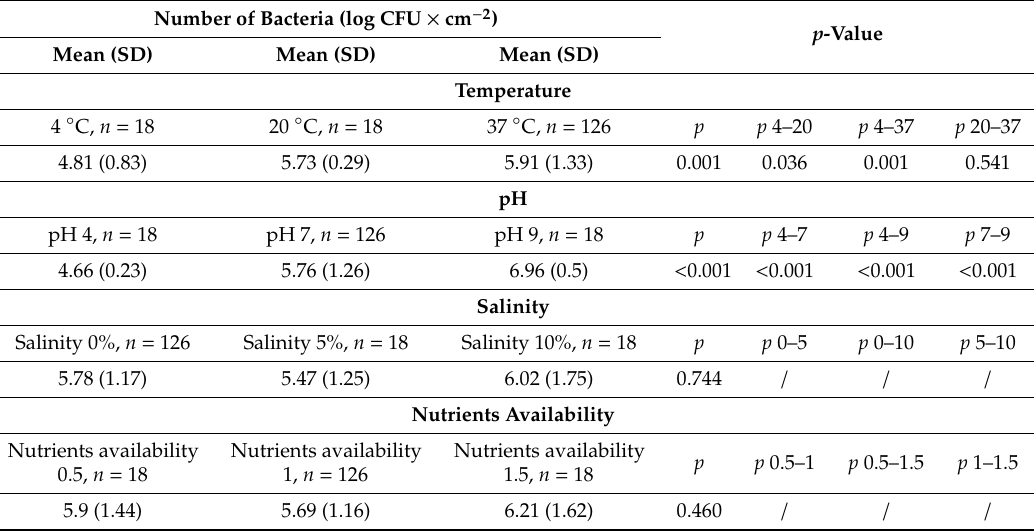
Table 2. Comparison of biofilm formation ability of L. monocytogenes strains under different environmental conditions.